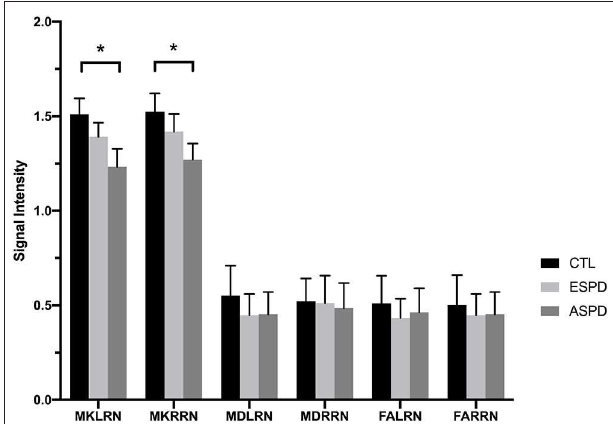
FIGURE 3 | Diffusion kurtosis imaging values in the red nucleus for the control, early-stage Parkinson’s disease, and advanced-stage Parkinson’s disease groups. ASPD, advanced-stage Parkinson’s disease; CTL, control; ESPD, early-stage Parkinson’s disease; MDLRN, mean diffusivity of the left red nucleus; FALRN, fractional anisotropy of the left red nucleus; FARRN, fractional anisotropy of the right red nucleus; MDRRN, mean diffusivity of the right red nucleus; MKLRN, mean kurtosis of the left red nucleus; MKRRN, mean kurtosis of the right red nucleus. * p < 0.05, ESPD vs. CTL or ASPD vs. CTL or ASPD vs. ESPD.